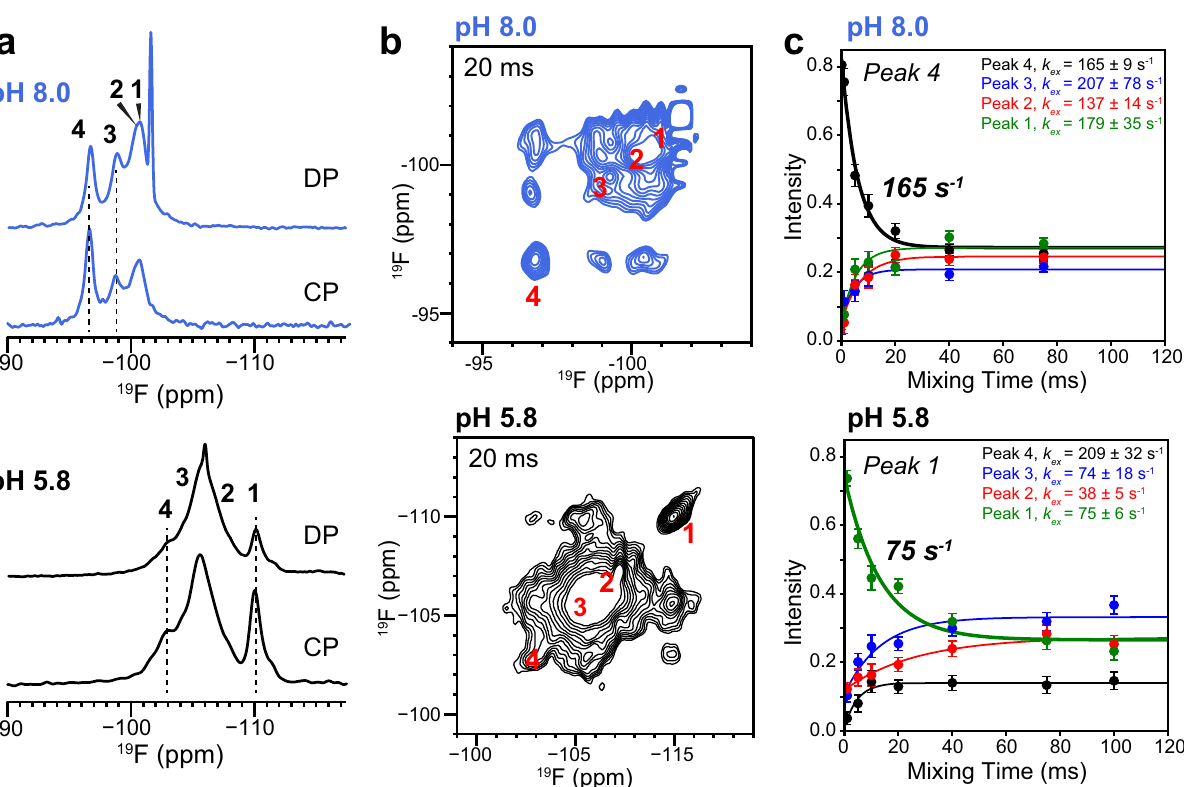
Fig. 5 19 F NMR spectra of F 4 -TPP + to probe substrate structure and dynamics. a 1D 19 F NMR spectra of F 4 -TPP + bound to EmrE at pH 8.0 and pH 5.8. Multiple 19 F chemical shifts are resolved, indicating heterogeneous structural environments of the four fl uorines. b 2D 19 F – 19 F correlation spectra of EmrE- bound F 4 -TPP + at pH 8.0 (blue) and pH 5.8 (black), measured with a mixing time of 20 ms. c 19 F exchange buildup and decay curves for the resolved peak 4 at pH 8.0 and the resolved peak 1 at pH 5.8. Data are presented as mean values + / − 2 σ . Error of intensity values was propagated from spectral signal to noise, while fi tting parameter errors were estimated by Monte Carlo methods. These 19 F spectra were measured under 38 kHz MAS at a sample temperature of ~285 K. Cross-peak intensities are provided as a Source Data fi le.